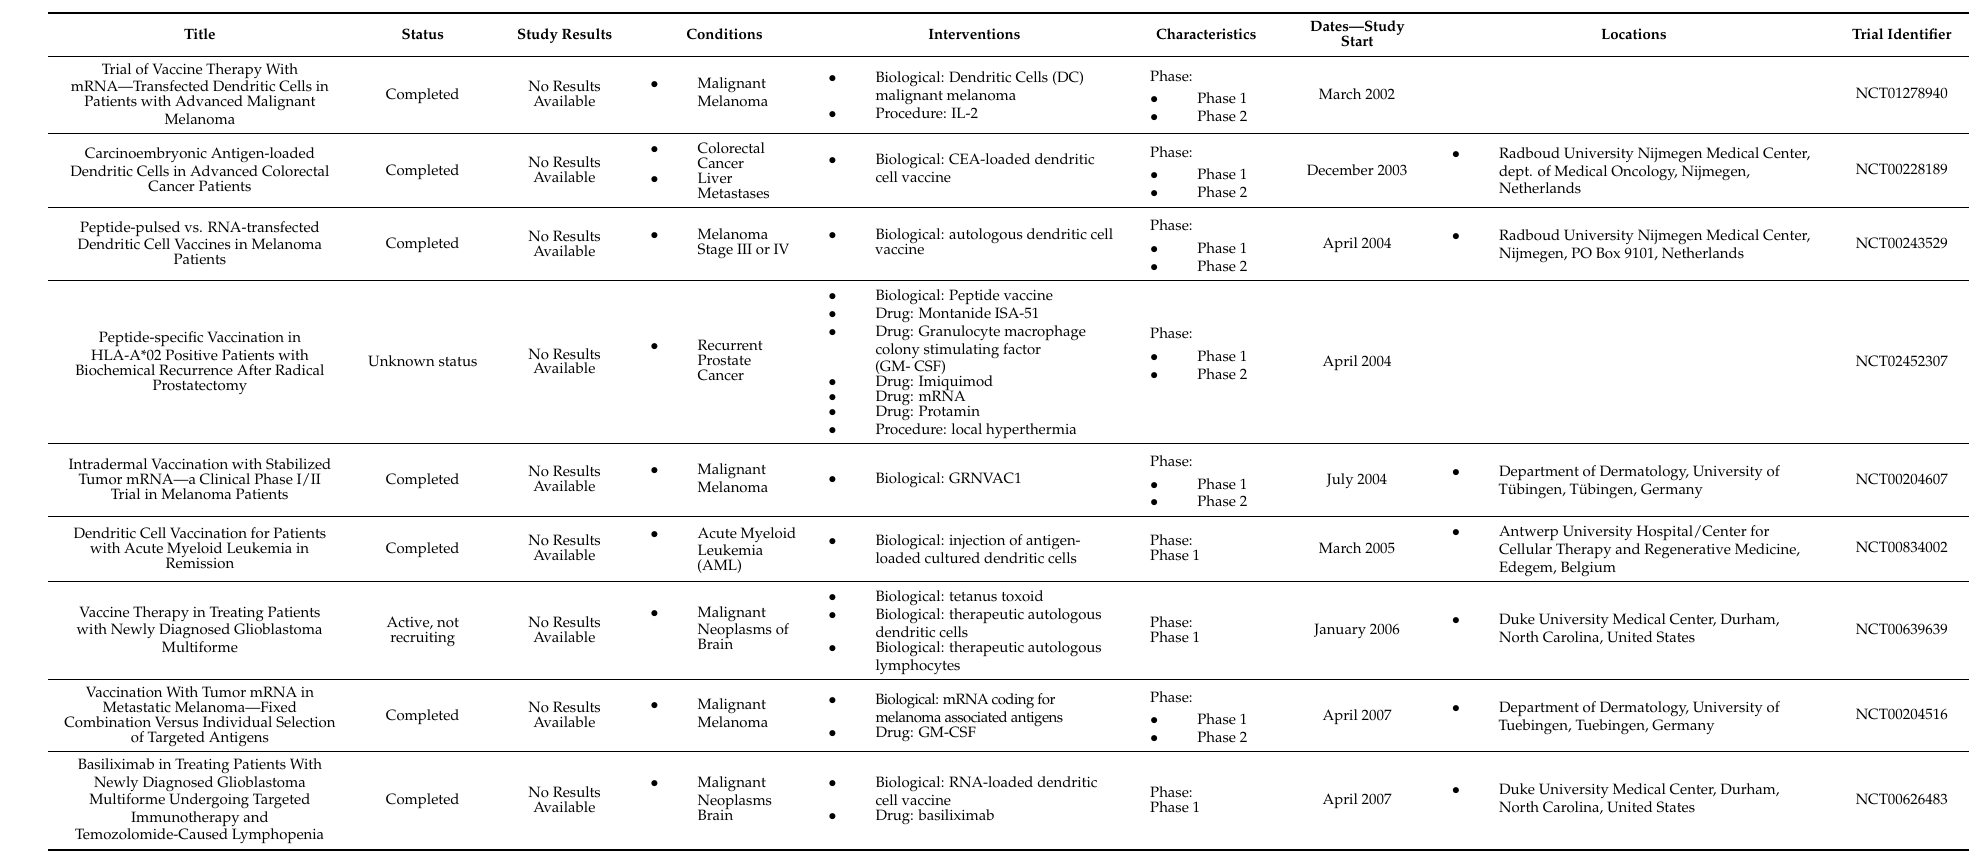
Table 2. ClinicalTrials.gov Search Results from 30 April 2022 for all mRNA-based cancer